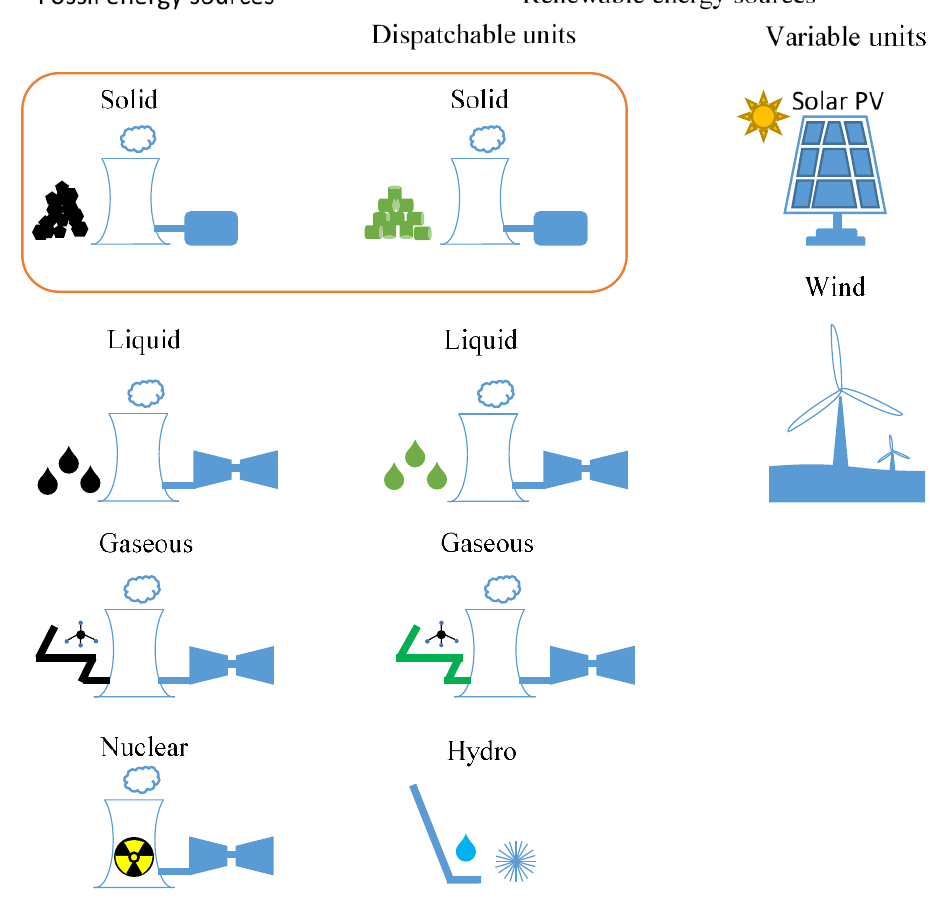
Figure 1. Classified energy sources of an electric system. The focus of this work is in the orange rectangle.